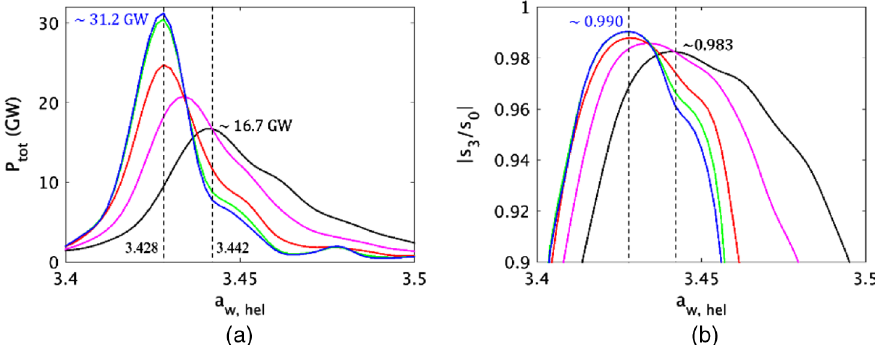
FIG. 4. Simulation results of the existing method (black lines) and the modified reverse tapering method with 1 (magenta lines), 2 (red lines), 3 (green lines), and 4 (blue lines) untapered planar undulators vs a w;